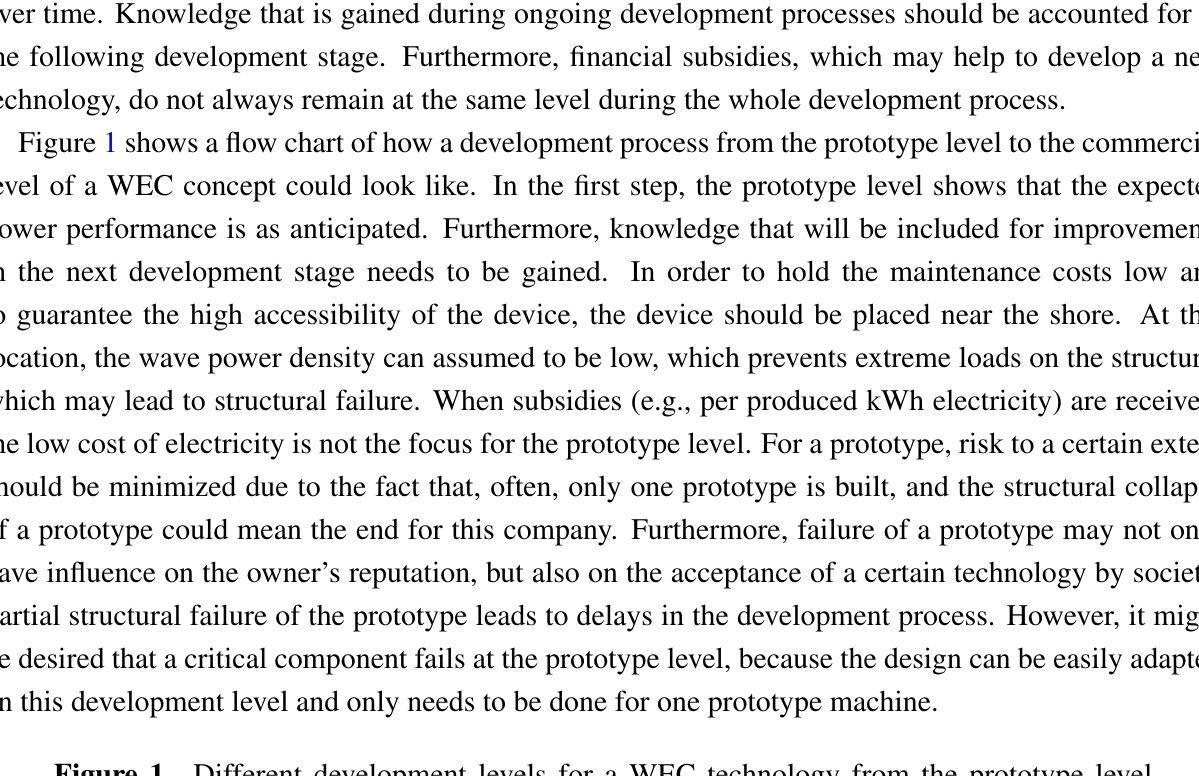
Figure 1. Different development levels for a WEC technology from the prototype level towards the commercial stage. LCOE, levelized cost of